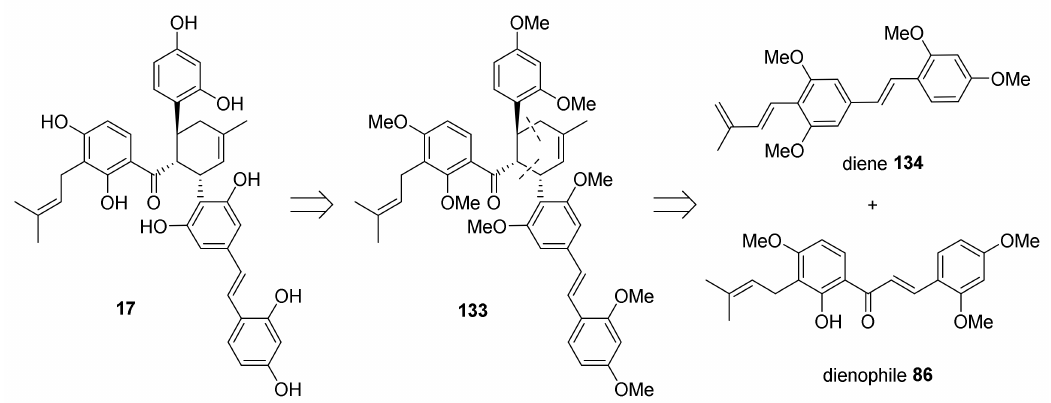
Figure 44. Retrosynthetic approach to kuwanol E ( 17